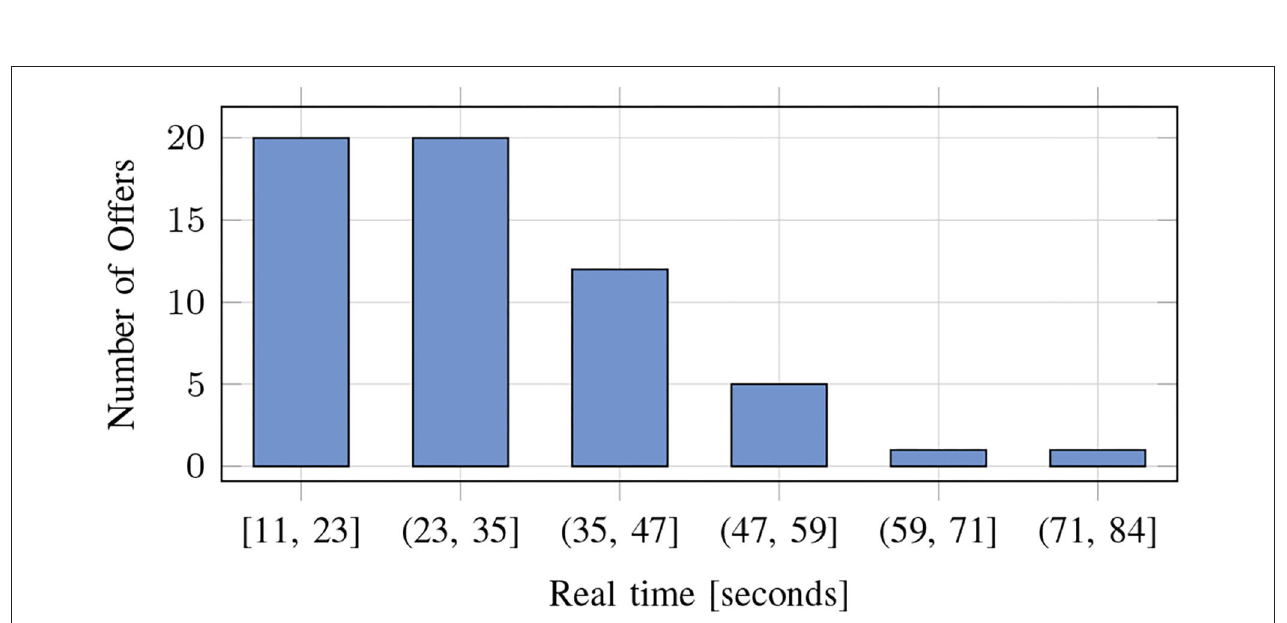
FIGURE 11 | Real time in seconds between posting an offer and recording a trade that ncludes the offer (test case C).